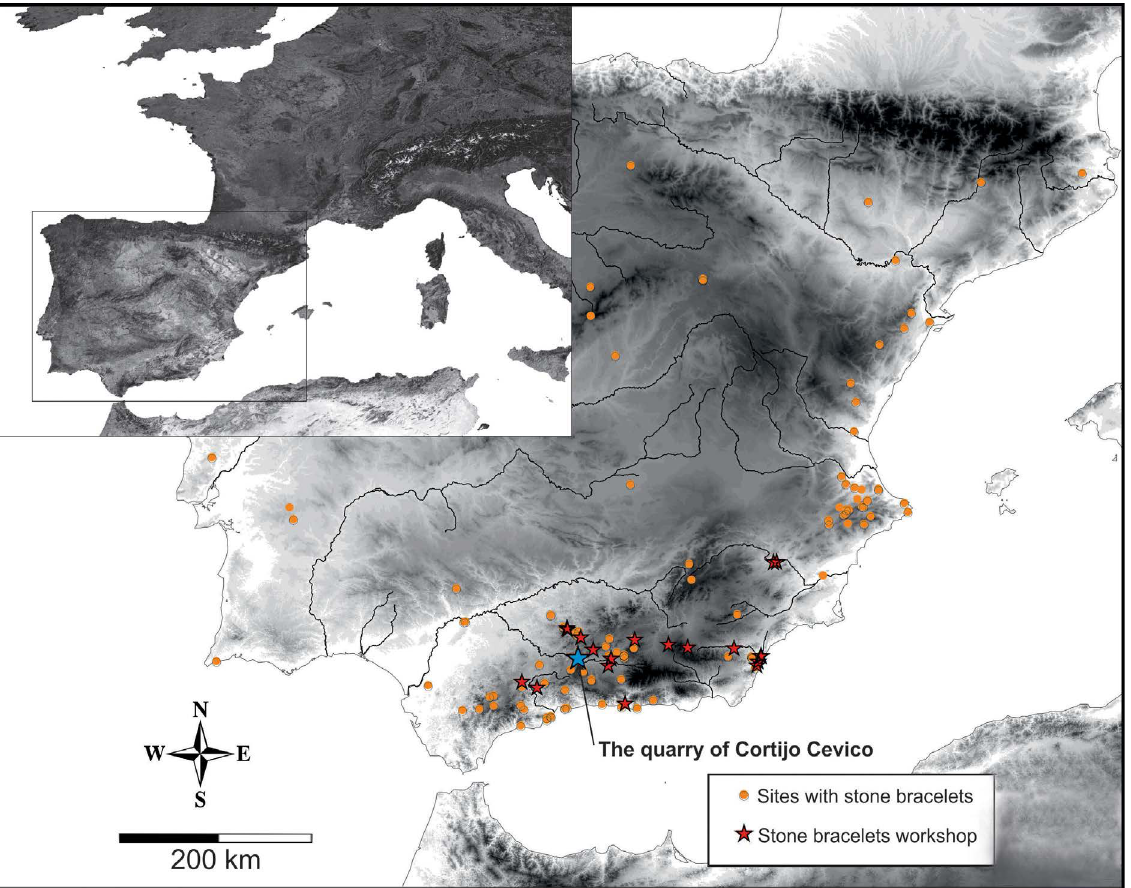
Figure 1. Situation of the quarry within the general context of stone bracelets and workshops. Table 1. The most representatives absolute dates of the bracelets workshops in the south of the Iberian Peninsula. Bracelets